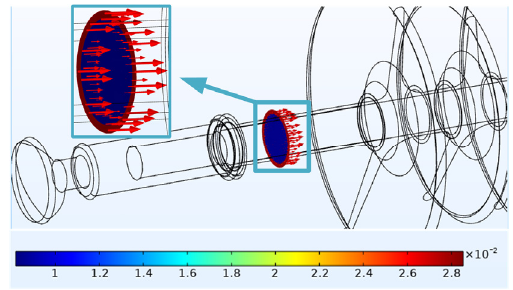
Figure 14. Current-density distribution of #2.